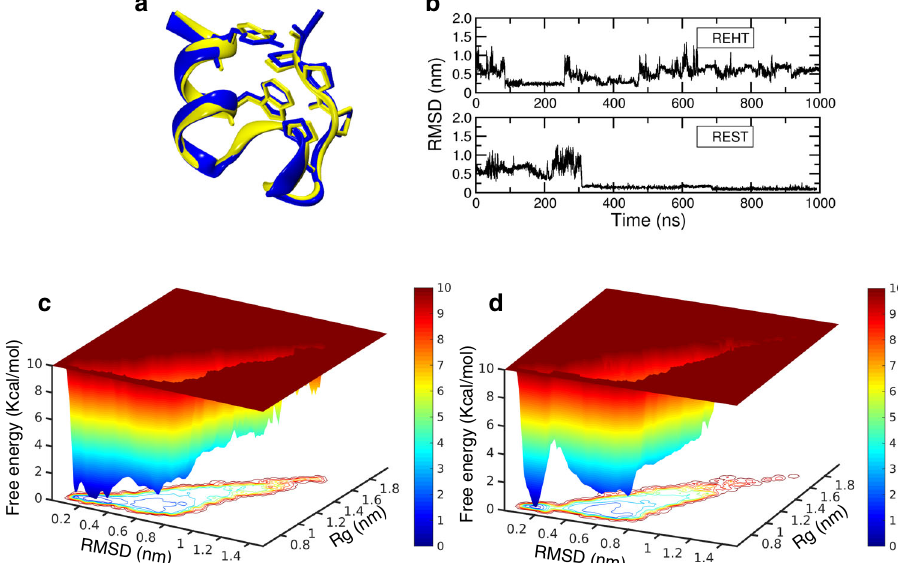
Fig. 2 Ef fi ciency of REHT in comparison to REST2 in capturing the folding of fast-folding protein, Trp-Cage. a Structural overlay between the natively folded NMR structure (blue) and the REHT-generated folded structure of Trp-cage (yellow, obtained at the base replica). b Time evolution of protein backbone RMSD from the NMR structure along one of the successfully folded replicas of REHT (top) and REST2 (bottom) simulations. The RMSD evolution of other folded replicas are shown in Supplementary Figs. 4 and 5. c , d Free energy landscape of Trp-Cage, shown as the function of Radius of gyration (Rg) and RMSD against the NMR structure. The landscape is shown for the ensembles collected at the base replica of c ) REHT simulation and d REST2 (Supplementary Figs. 3b, 4). The REST2 simulations sample the folded structure of TRP-cage (Fig. 2b) and β -hairpin (ref. 16 ) at around 300 ns. Moreover, only 1 – 2 replicas out of 8 replicas are independently folded in these simulations (Supplementary Fig. 5